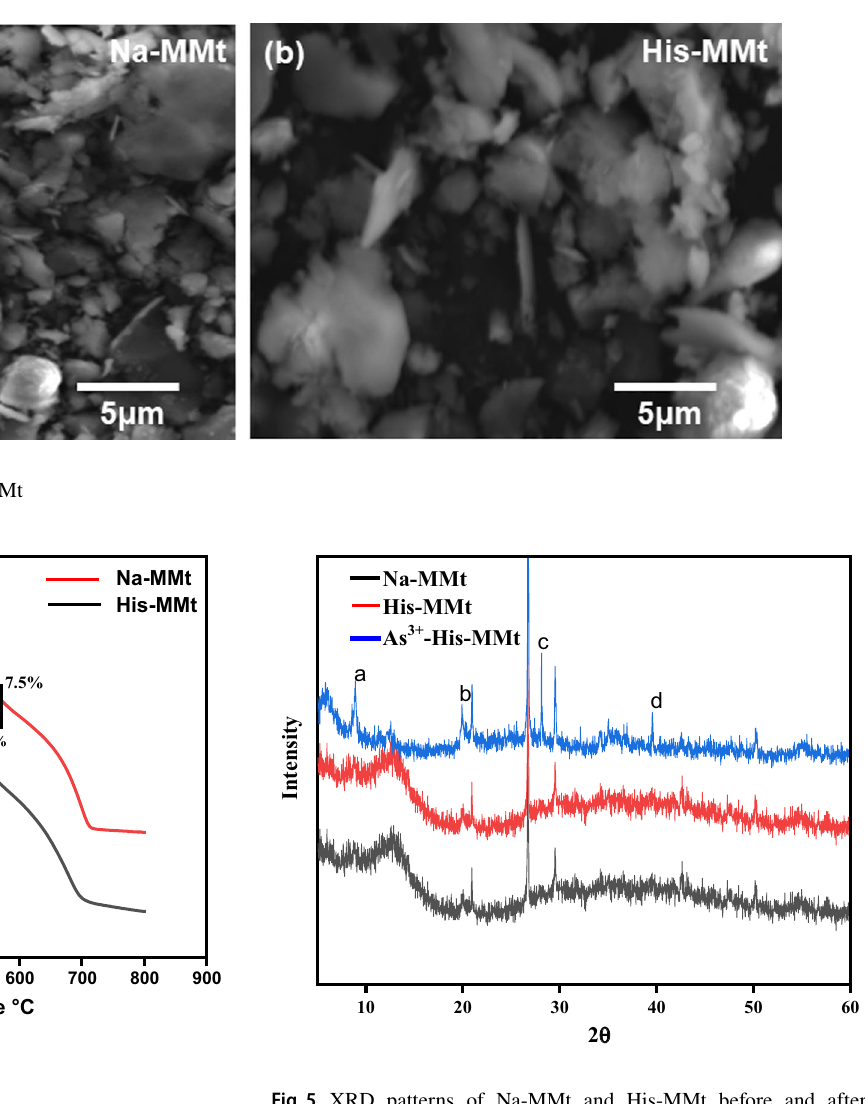
Fig. 5 XRD patterns of Na-MMt and His-MMt before and after adsorption of As(III)